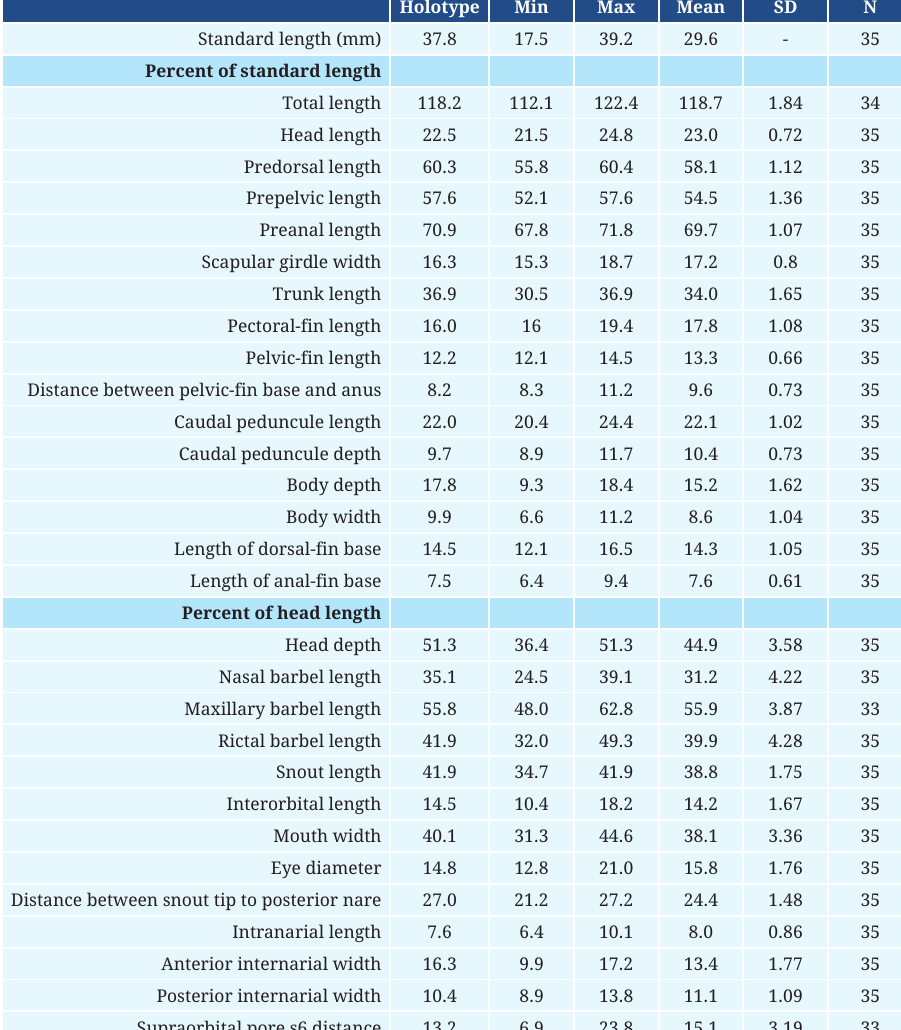
TABLE 7 | Morphometric data of Scleronema milonga , new species (data of holotype included in the range). N = number of specimens; SD = standard